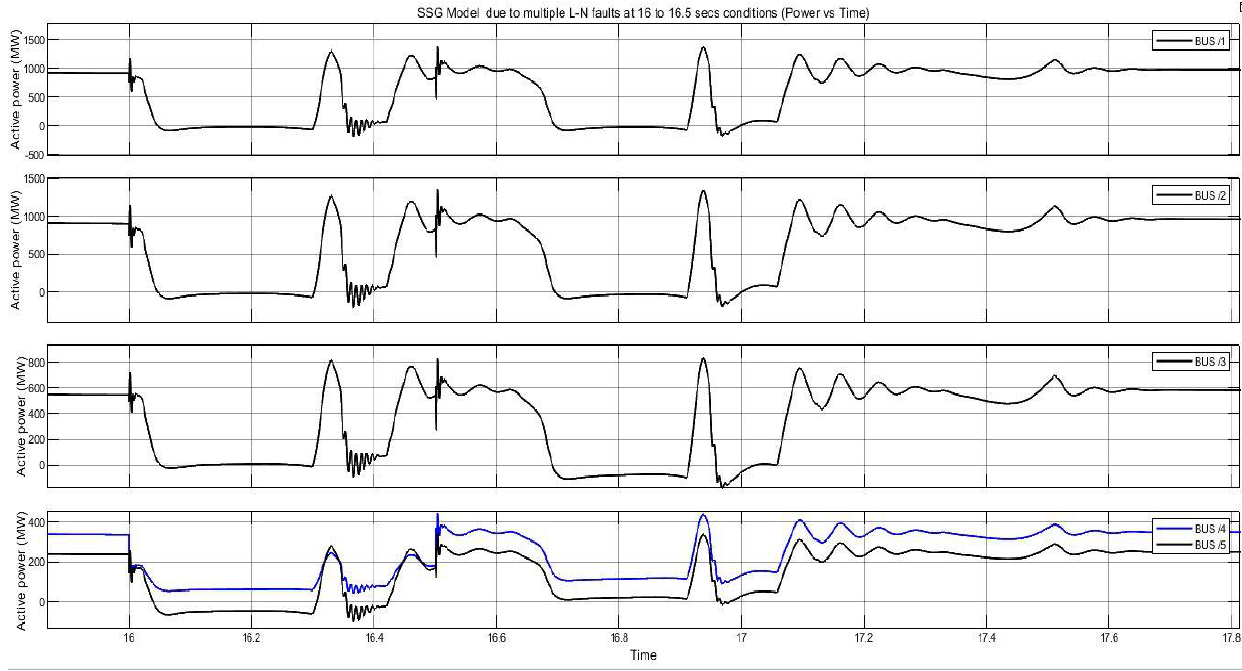
Figure 24. Multiple double line-to-line (L-L) faults are inserted in the system from 16 to 16.5 s (Bus 1 to Bus 5).